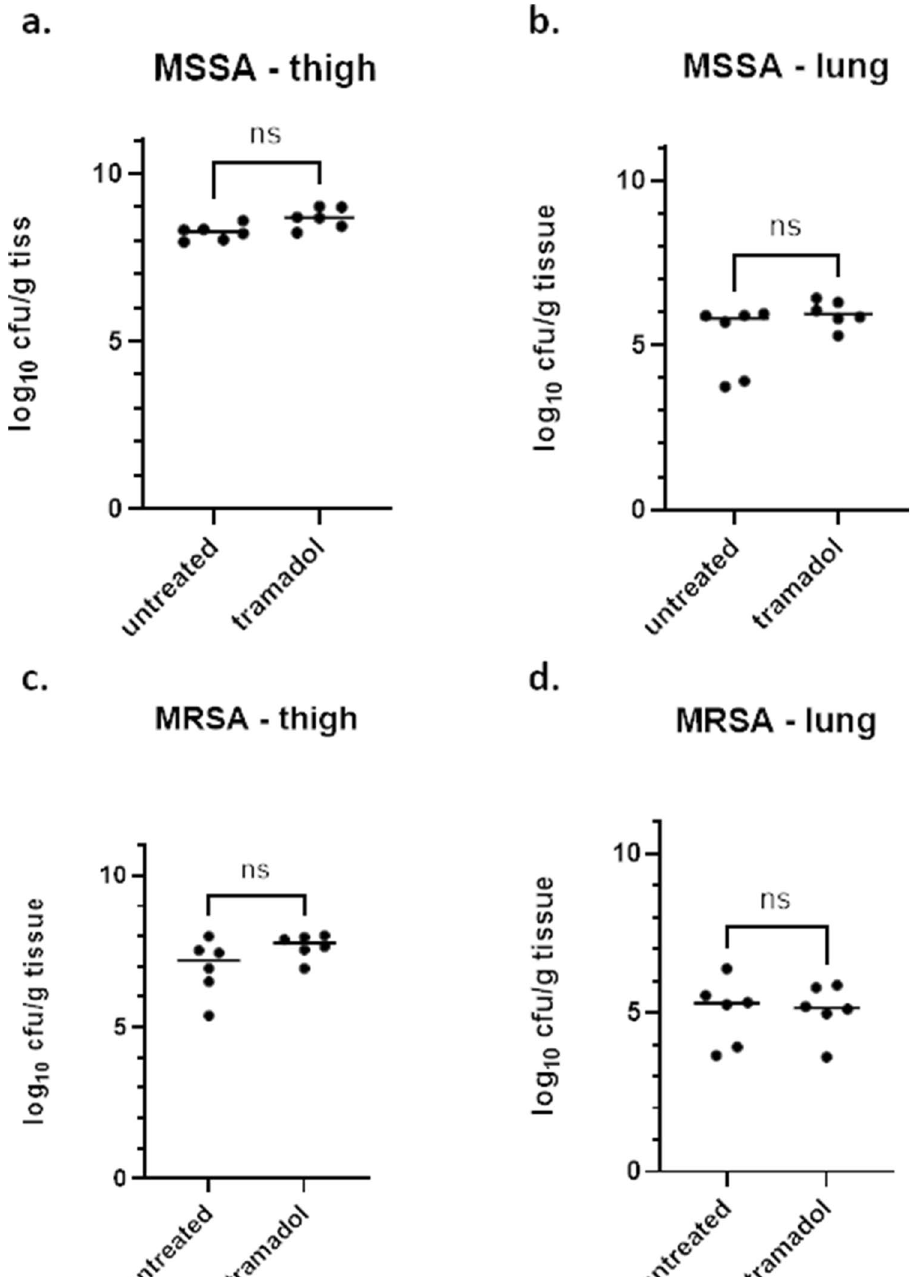
Figure 2. Bacterial burden in untreated and tramadol-treated groups in the neutropenic thigh infection model with two different strains of S. aureus. Bacterial burden expressed as cfu/g tissue was assessed for groups that were treated with either 20 mg/kg tramadol subcutaneously or left untreated (n = 6 per group). All groups were infected with MSSA ( a,b ) or MRSA ( c,d ). Bacterial burden was assessed in thigh ( a,c ) and lung ( b,d ). Statistical testing was performed using a Kolmogorov–Smirnov test. Ns not